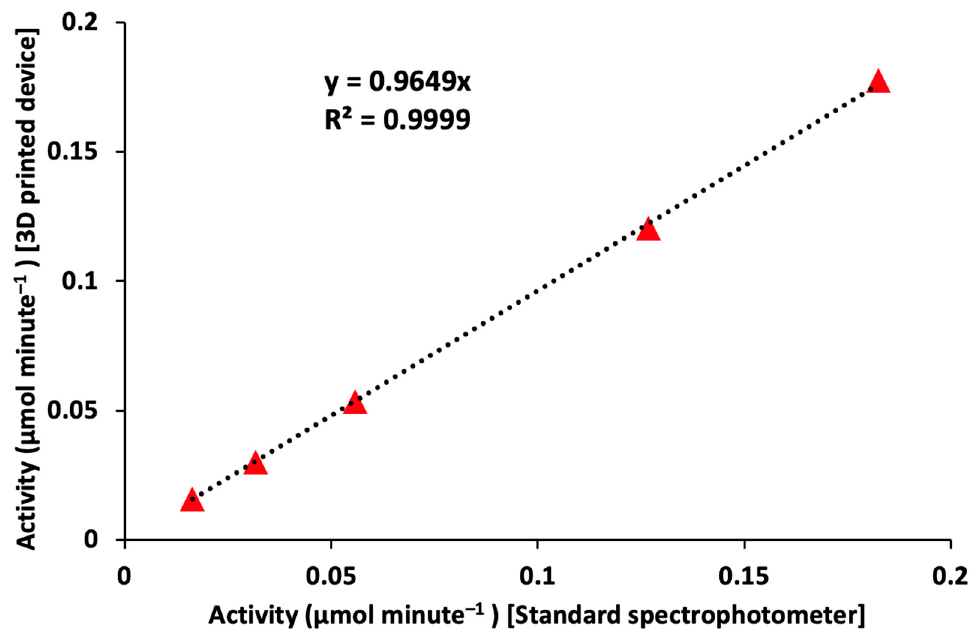
Figure 7. Correlation plot of the measured enzyme activity at different reaction rates between the control instrument spectrophotometer and the 3D-printed spectrophotometer.